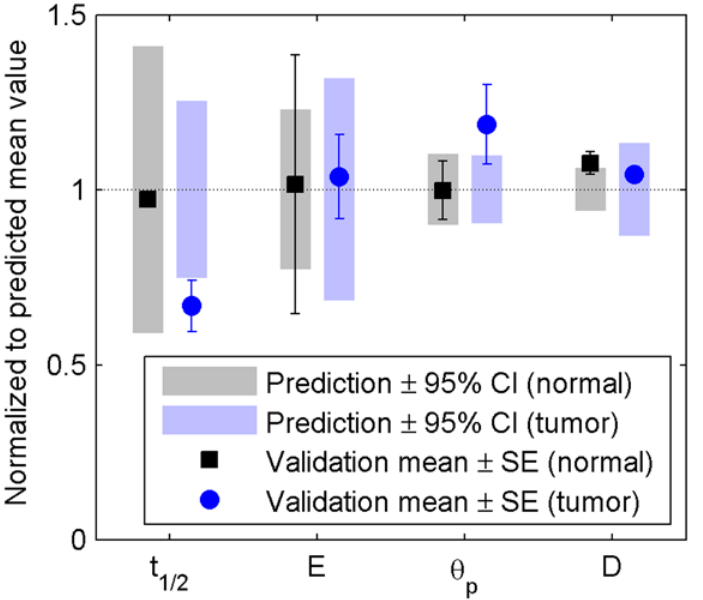
Fig 10. Validation of model for design of tuned hydrogels. Each parameter is normalized to the target value (predicted mean). Symbols with error bars represent the mean and standard error of the validation data set. Shaded bars indicate the upper and lower 95% confidence interval on the predicted mean value, obtained from JMP. The validation set targeted to mimic normal breast tissue is plotted in gray/black (squares) while the set targeted to mimic cancerous breast tissue is plotted in blue